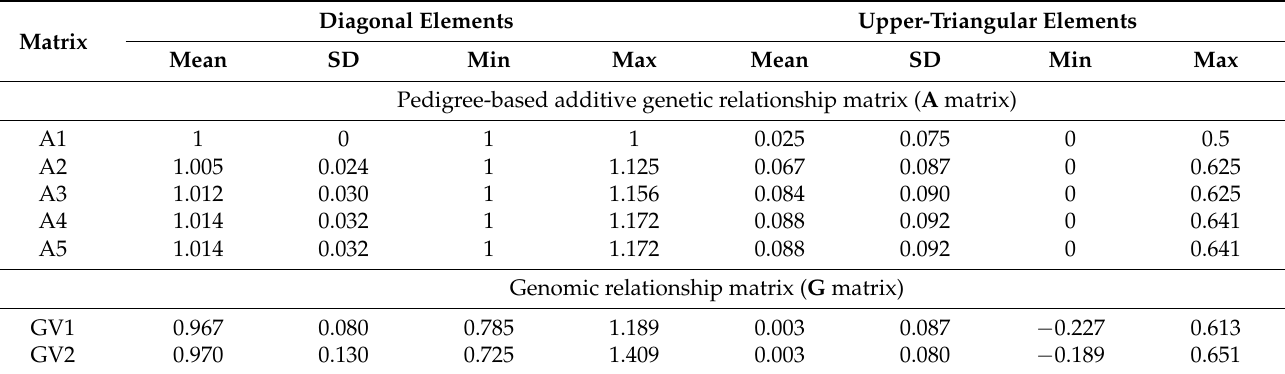
Table 2. Basic statistics of the elements of the seven relationship matrices for the 575 cows.